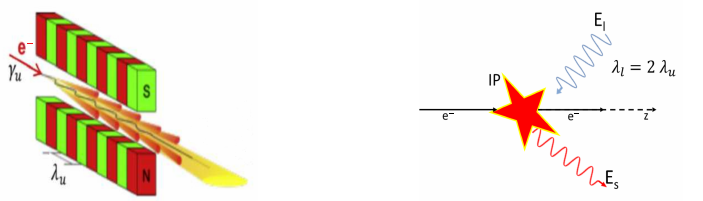
Figure 3. Emissionin undulator macroscopic picture ( left ) and microscopic picture ( right ); IP stands for interaction